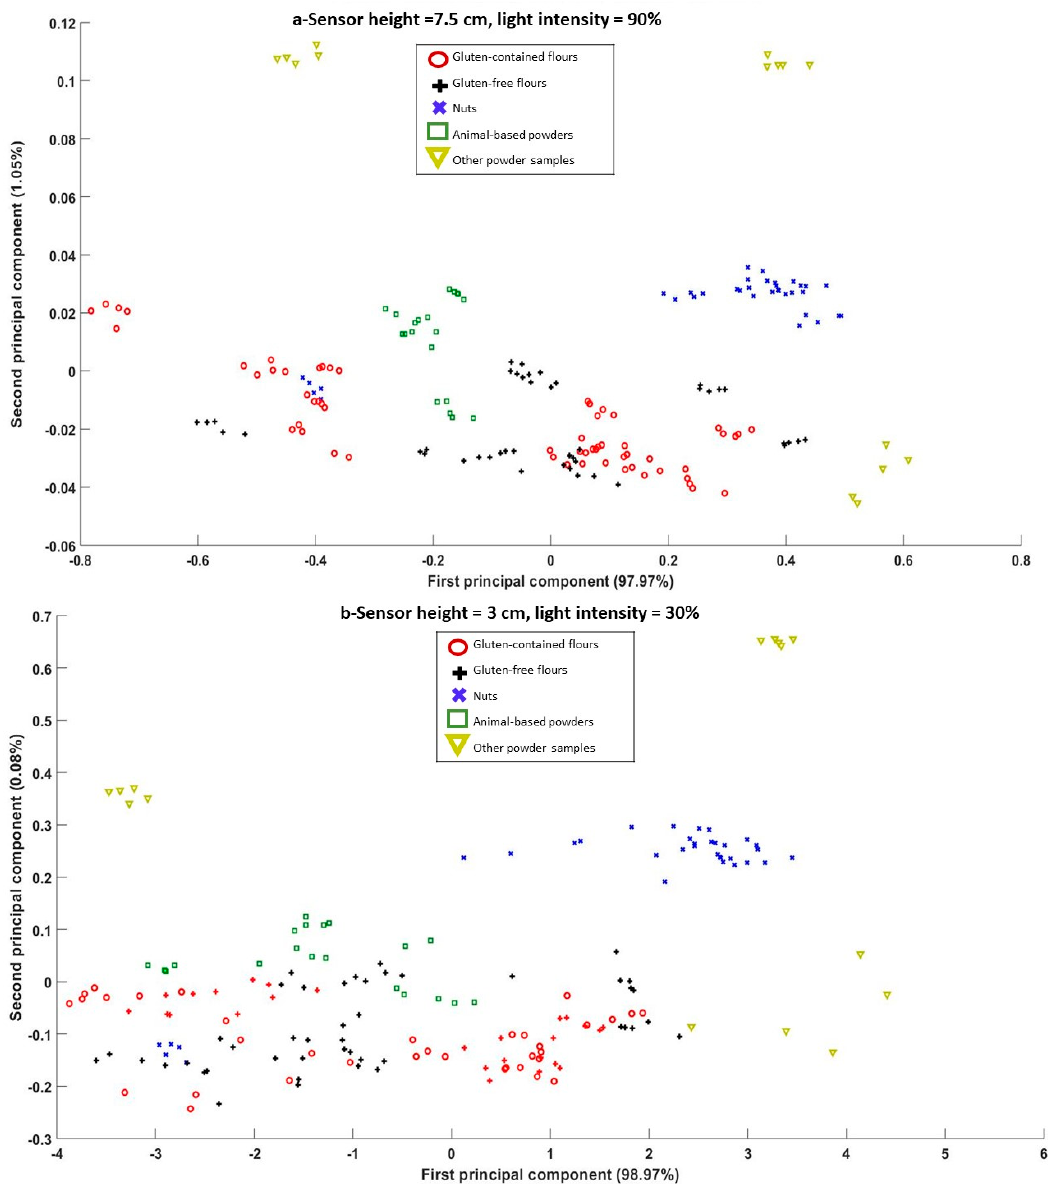
Figure 6. Principal component analysis (PCA) Scatter plots for different flour powder samples scanned by an NIR sensor at ( a ) sensor height level = 7.5 cm and light intensity = 90%, and ( b ) sensor height level = 10.5 cm and light intensity = 30%.